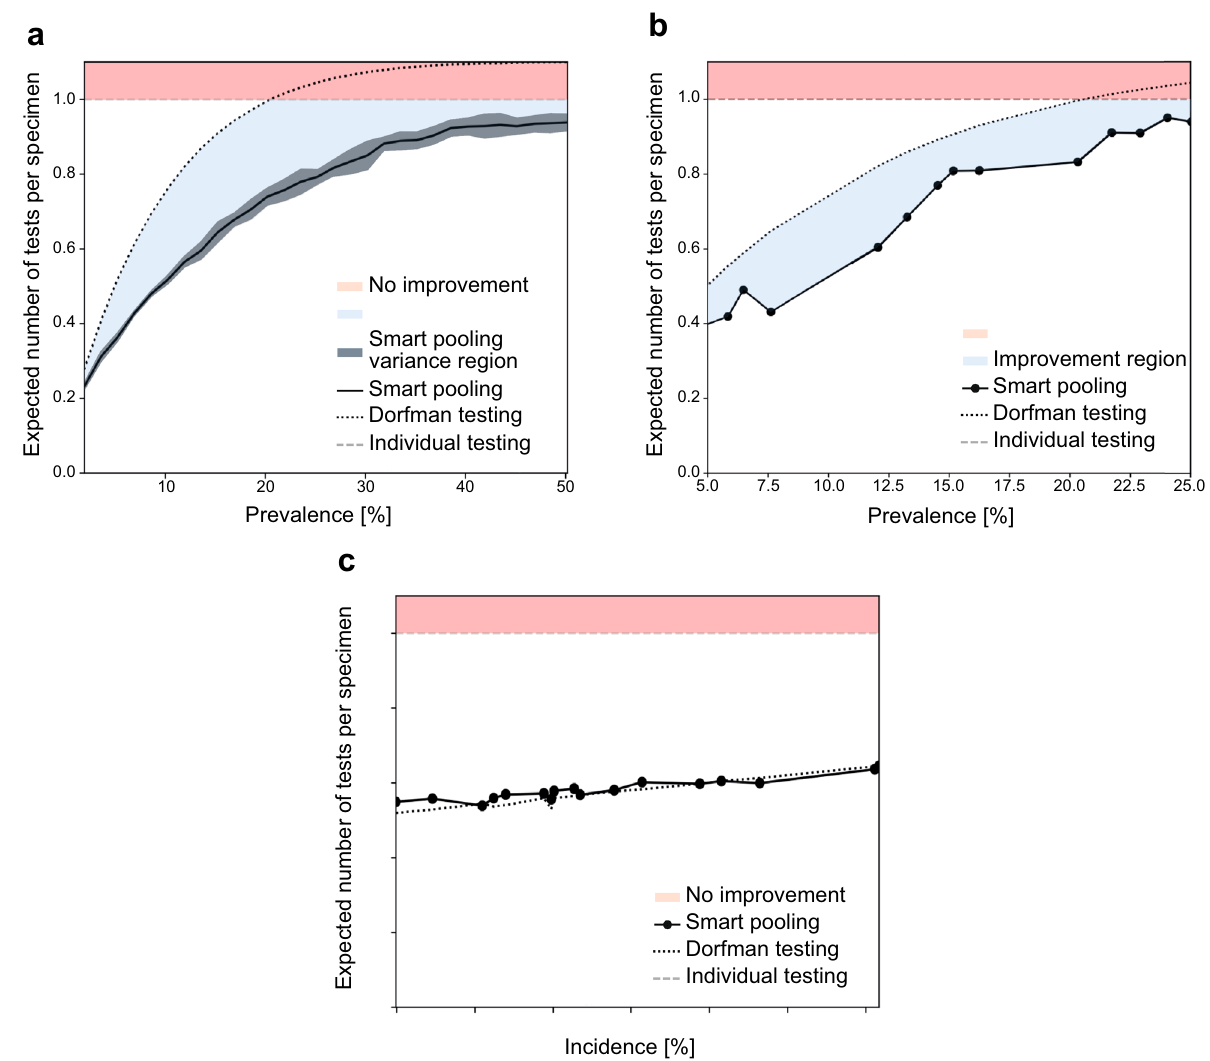
Figure 2. Smart Pooling decreases the expected number of tests per specimen. ( a ) Smart Pooling’s expected number of tests per specimen compared to standard testing methods on Patient Dataset. Efficiency improves by reducing the expected number of tests per specimen. Smart Pooling achieves higher efficiencies than Dorfman’s and individual testing for prevalences of the disease of up to 50%, with a fixed pool size of 10. ( b ) Smart Pooling’s expected number of tests per specimen trained with the coarse metadata from the Test Center Dataset. Efficiency improves by reducing the expected number of tests per specimen. Despite not having detailed patient metadata, Smart Pooling can produce higher efficiencies than Dorfman’s pooling for the simulated prevalence of the disease of up to 25%, with a fixed pool size of 10. ( c ) Expected number of tests per specimen for the proof-of-concept Smart Pooling Implementation. Each point on the graph represents the performance of both methods for a day in the proof-of-concept stage. The x-axis depicts the incidence of the corresponding day. Efficiency improves by reducing the expected number of tests per specimen. Smart Pooling has a similar efficiency compared to Dorfman’s testing since the daily incidence is lower than 10%. However, for every day of the implementation, Smart Pooling has a higher efficiency than individual